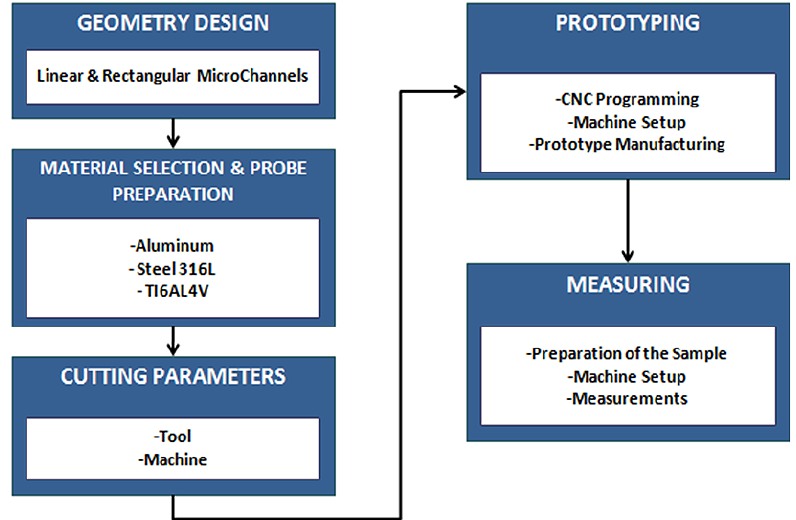
Figure 3. Experimental process of micro-milling manufacturing of